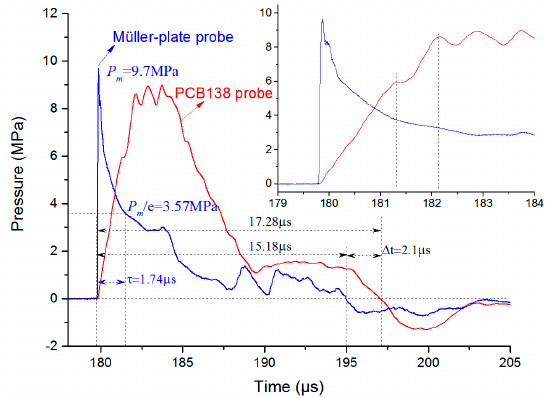
Figure 9. Typical time-dependent pressure waveforms obtained with both pressure probes at the distance of 260 mm. distance of 260